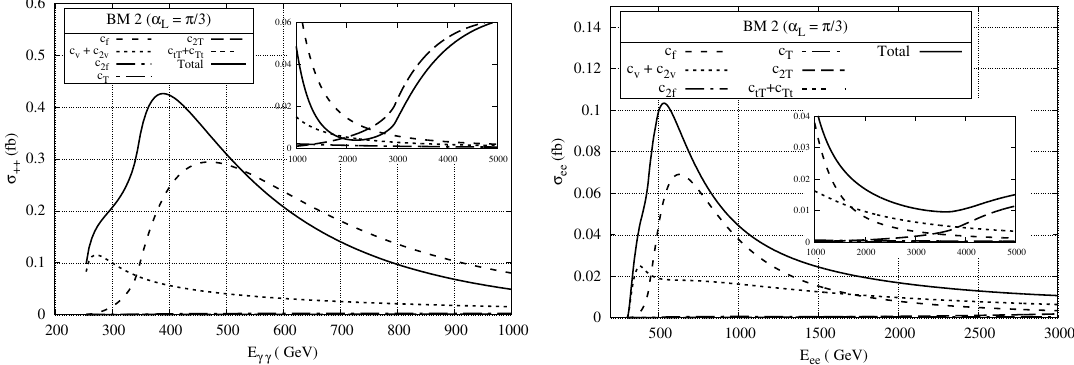
Figure 17 . Cross-sections for the individual contributions as given in tables 1 and 6 for γγ → hh same photon helicities (left panel) and e + e − → hh (right panel) in the presence of Doublet Vector Like Top-quark (as given in section